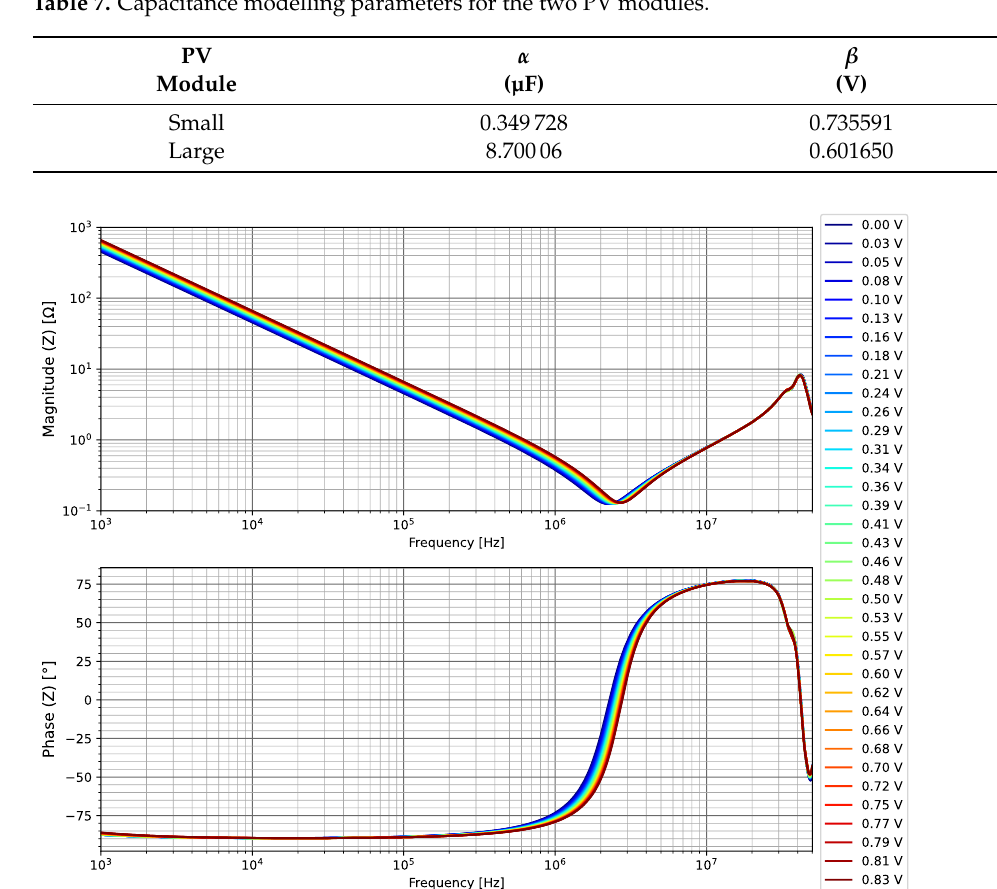
Figure 27. Small PV module measured per-cell impedance curves at multiple levels of reverse bias (frequency range 1 kHz to 50